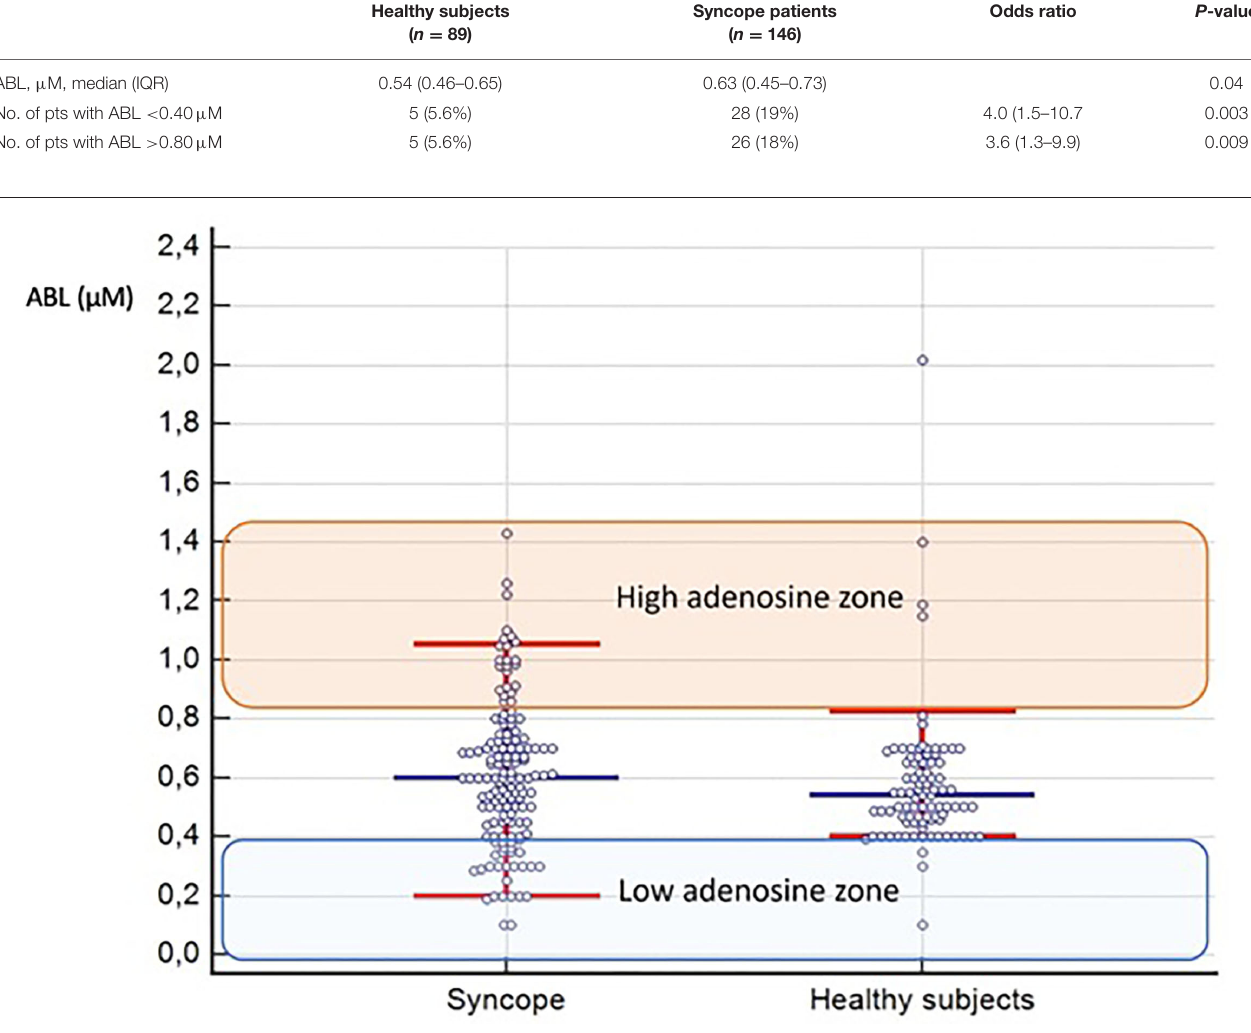
FIGURE 1 | Distribution of patients with syncope and healthy controls based on their adenosine levels. The blue horizontal line shows the median; the red horizontal lines show the 5th and the 95th percentiles of the two groups. The low adenosine zone and the high adenosine zone, based on the normal ABL range in control subjects, are identified as